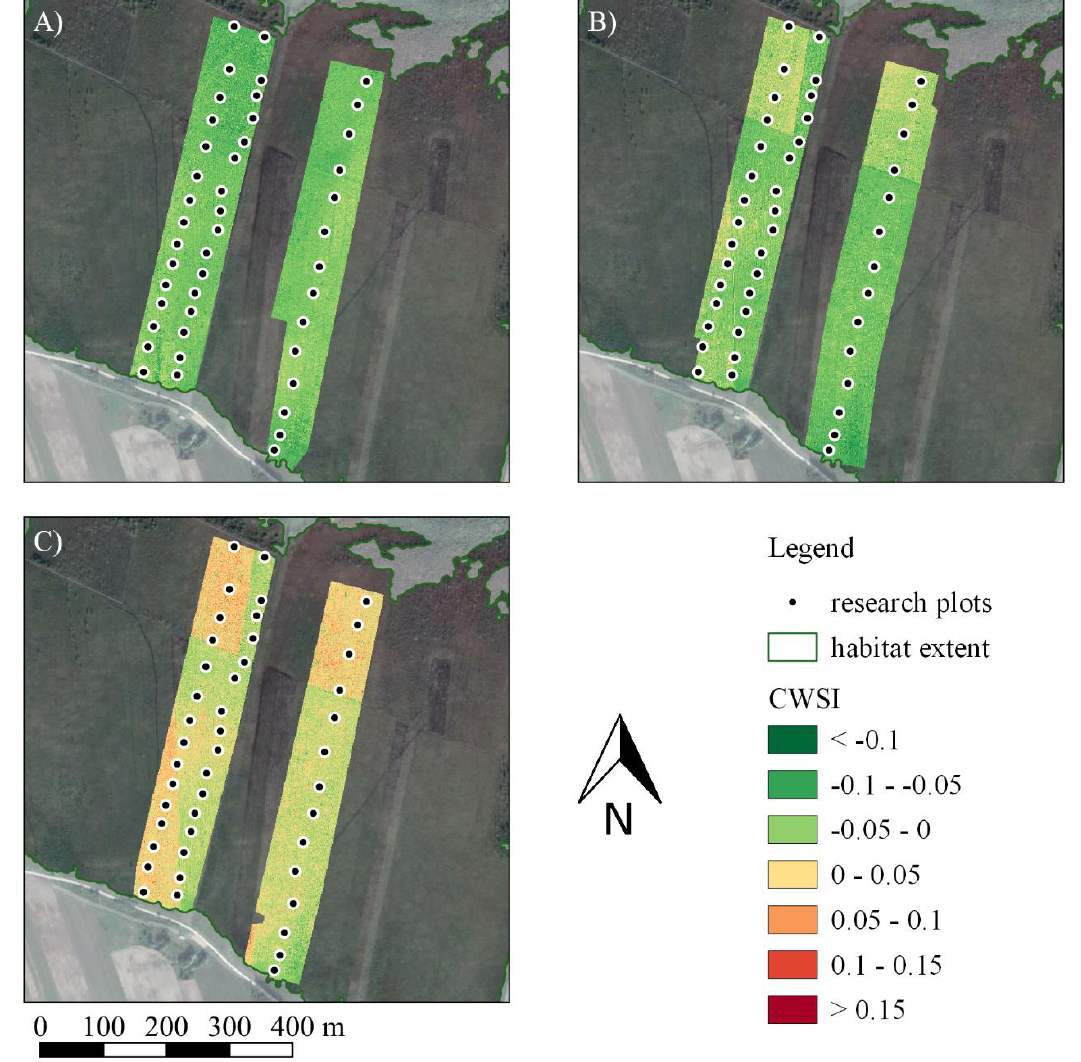
Figure 3. The spatial distribution of crop water stress index (CWSI) with the location of research plots in the Biebrza National Park for 3 unmanned aerial system (UAS) campaigns in 2016: ( A ) 24 July, ( B ) 7 September, and ( C ) 15 September.